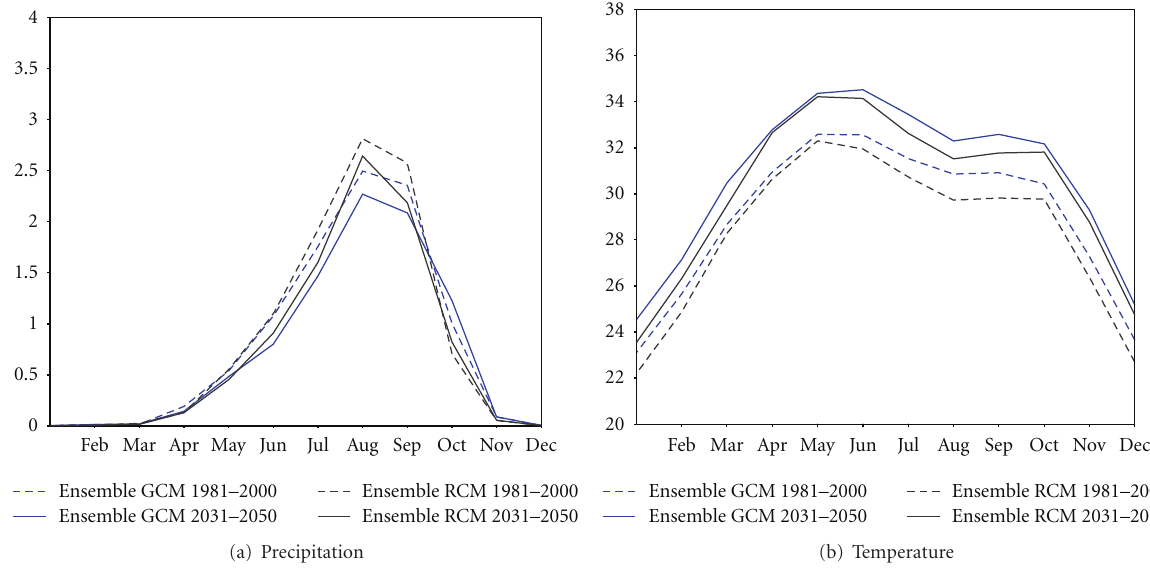
Figure 14: Present-day and future annual cycles of simulated precipitation (in mm/day; (a)) and temperature (in ◦ C; (b)) from: mean ensemble of the two GCMs and multi-model ensemble mean of the four RCMs over Western Sahel. The present day is represented by dashed lines and the future by solid